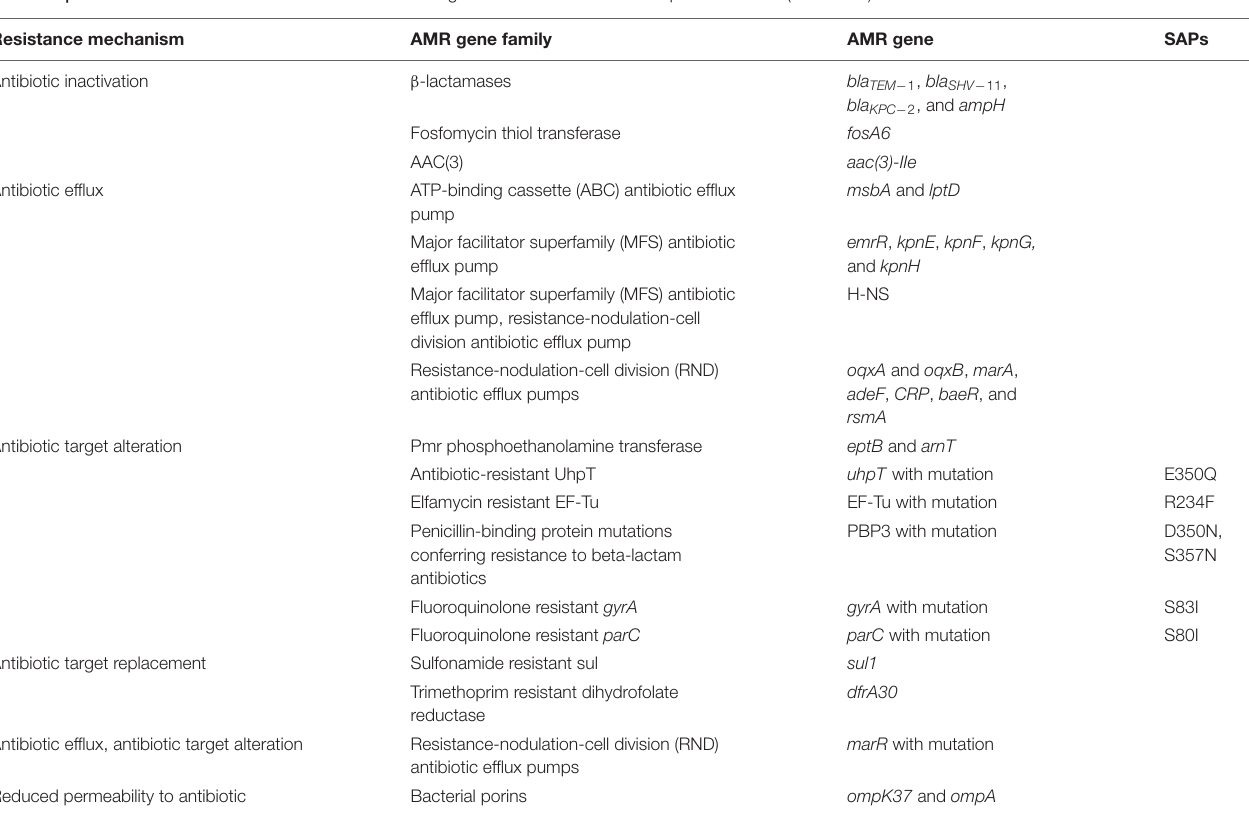
TABLE 4 | Predicted resistome other than colistin resistance genes of one ColR-CRKP sequenced isolate (HGRS058). Resistance